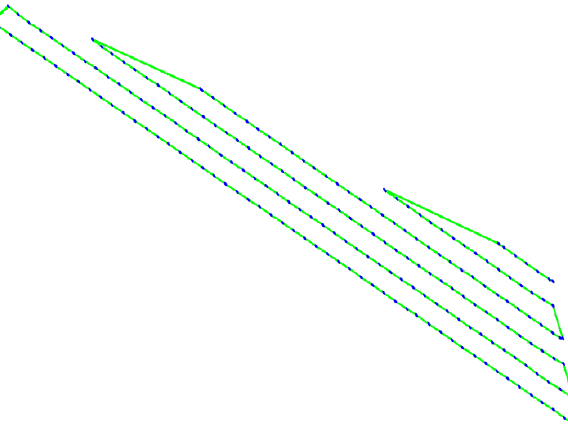
Figure 13. Flying path for the experimental run.